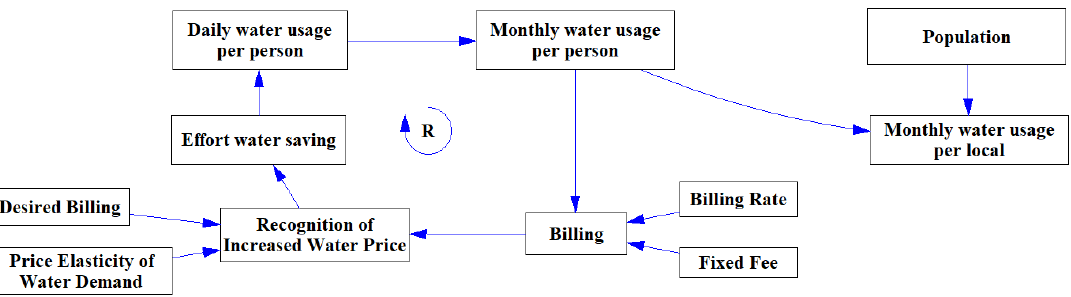
Figure 4. Structure of the SD model.